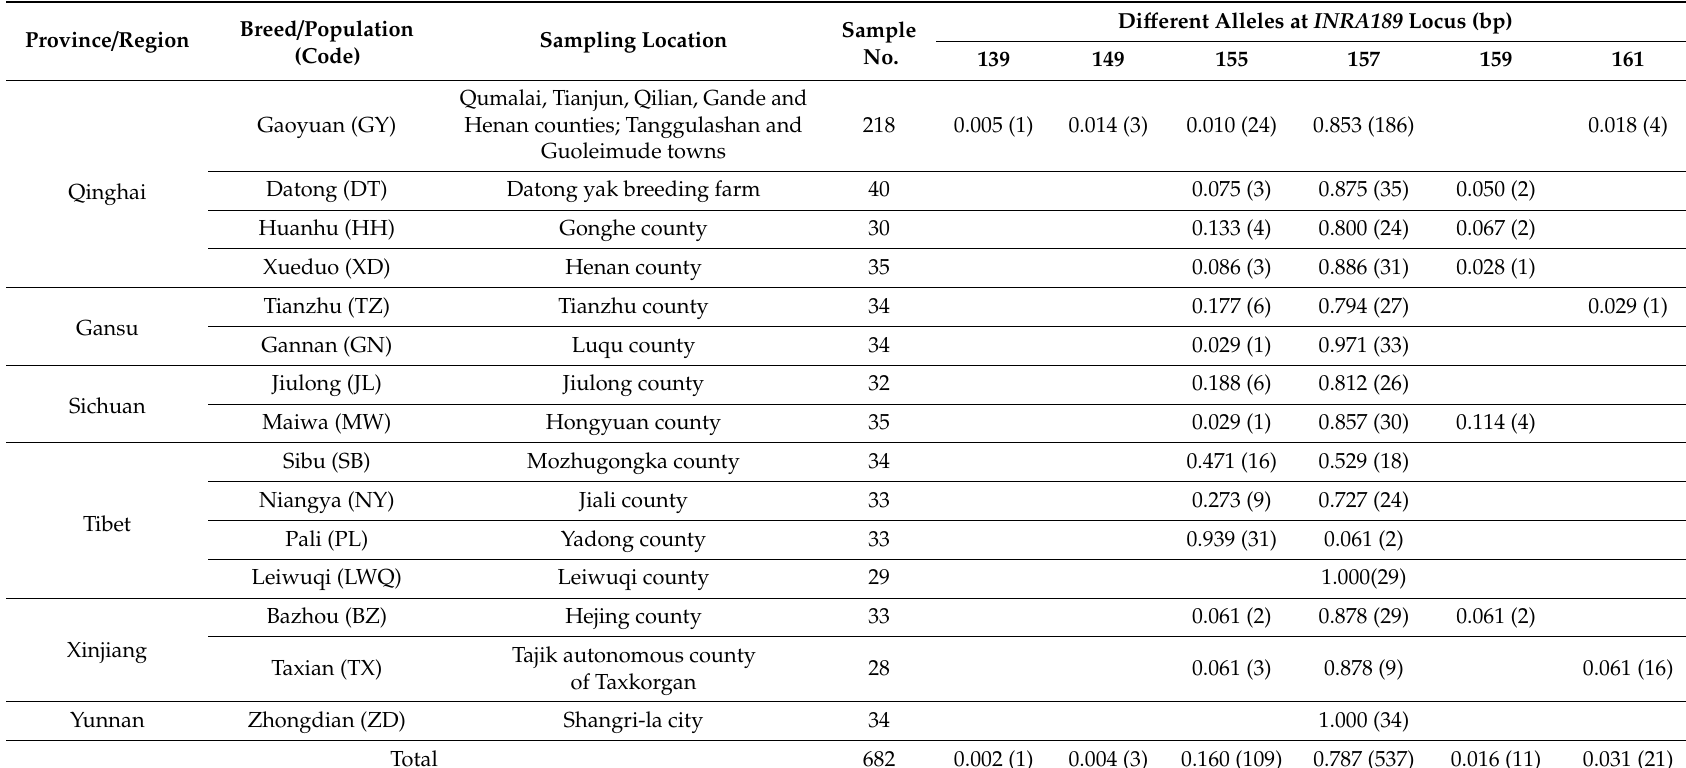
Table 1. Allele frequencies at INRA189 locus in 15 Chinese yak breeds /